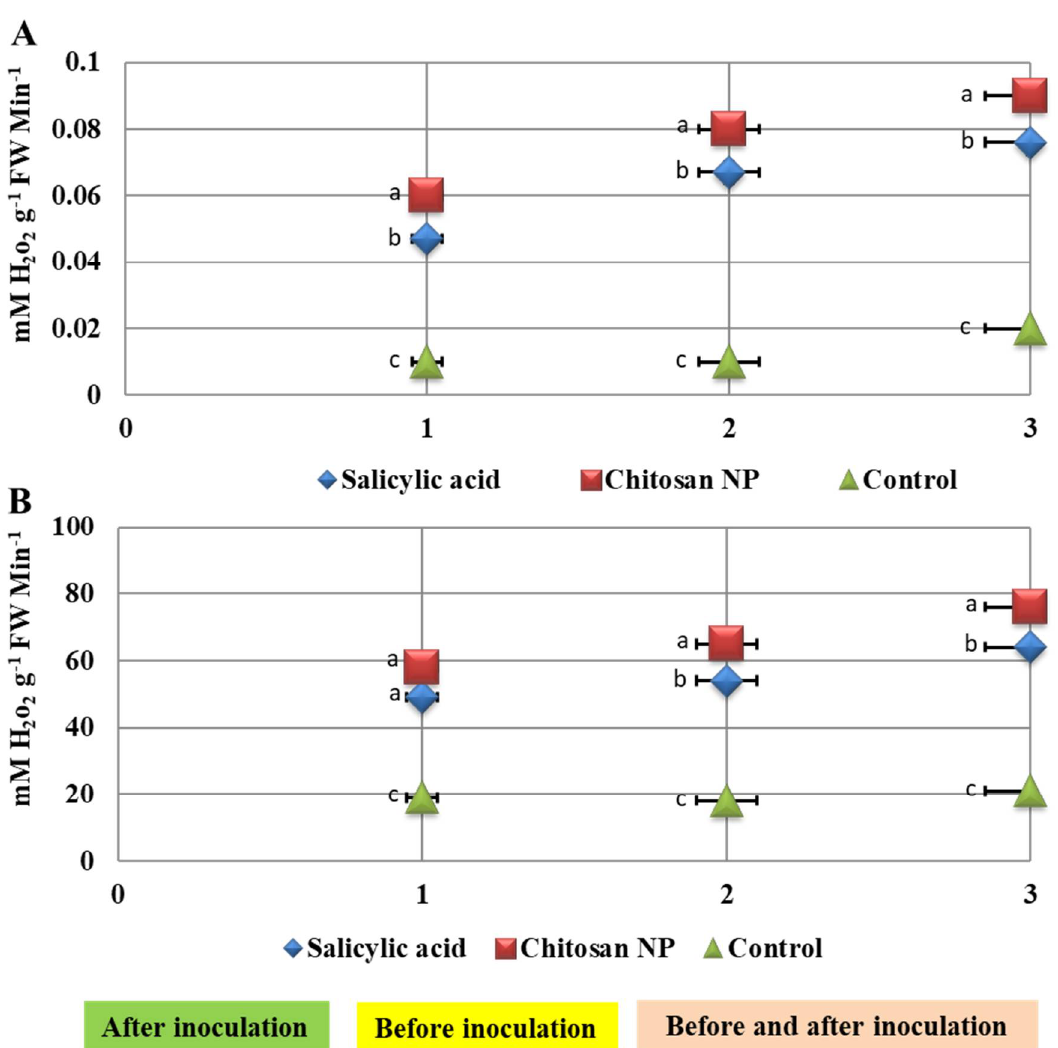
Figure 6. Effect of salicylic acid and chitosan nanoparticles application methods (1 = spray before inoculation by 24 h, 2 = spray after inoculation by 24 h and 3 = spray before and after inoculation by 24 h) on peroxidase ( A ) and catalase ( B ) activities in wheat leaves infected with Puccinia triticina . The letters (a, b and c) denote significant difference.